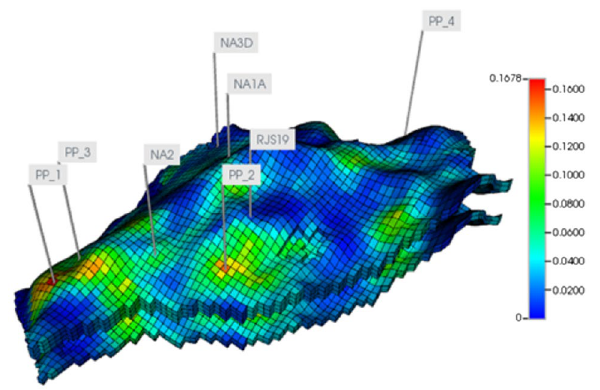
Fig. 4 Illustration of PP_1 to PP_4 wells placed at best PP C and the PP best five L